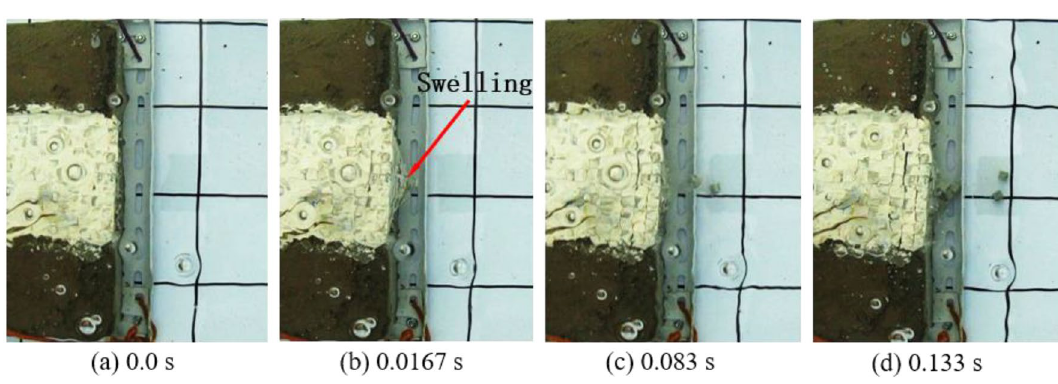
Figure 4. Underwater motion of blocks under a charge of 0.6 g.